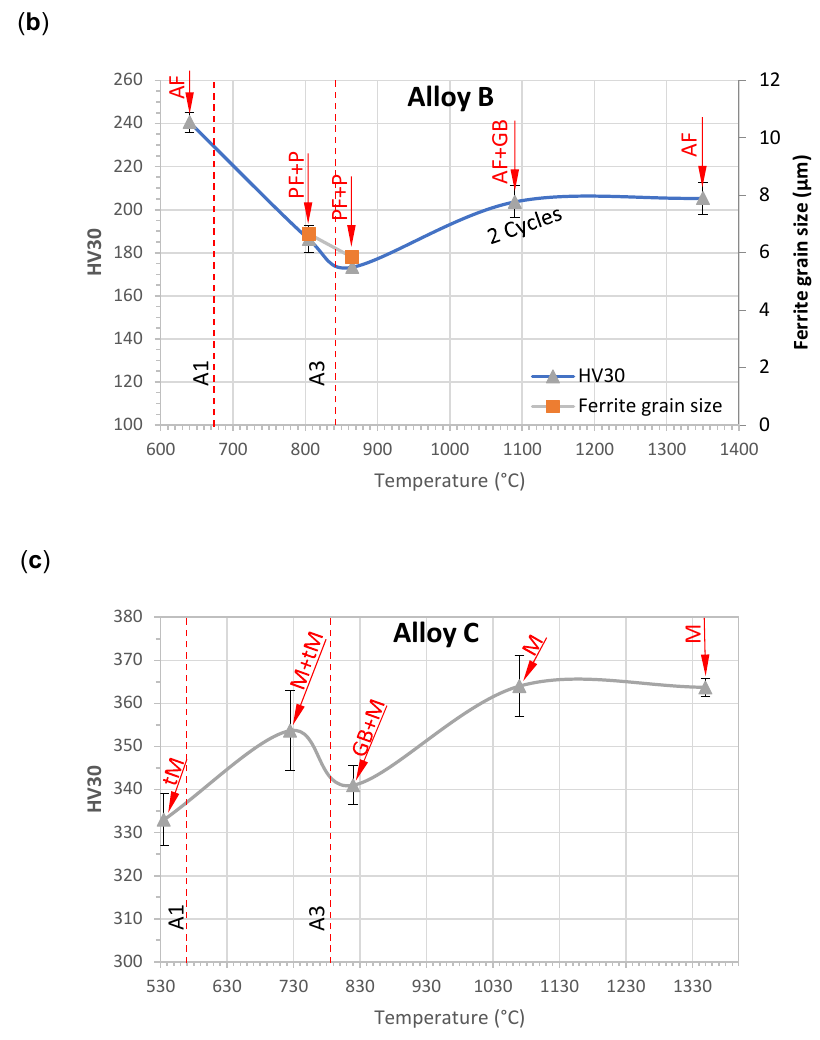
Figure 11. Dependence of hardness and ferrite grain size on the treatment temperature of alloys A, B and C. The developed microstructures are also designated on the diagrams at the respective treatment temperature. Table 3. Transformation temperatures under equilibrium together with those recorded during heating and cooling applying different thermal cycles. St: start and Fi: finish. Under the present conditions no significant difference was found between 2 and 4